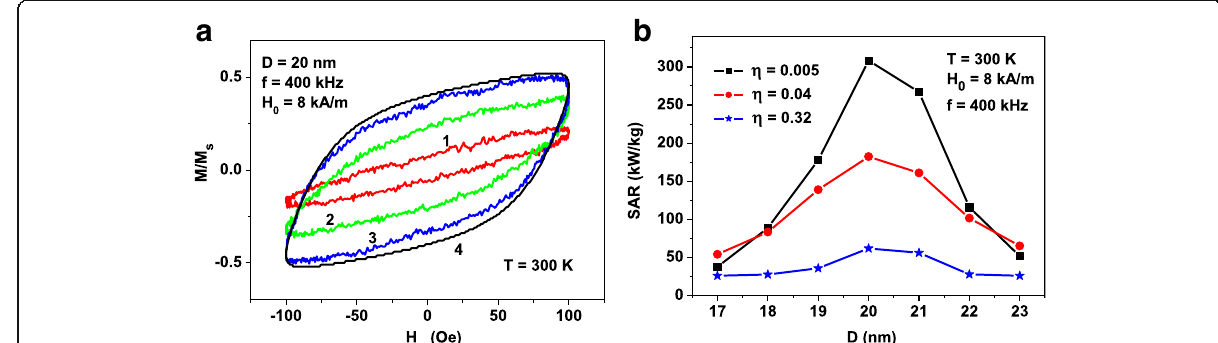
Fig. 3 ( a ) Evolution of the hysteresis loops of dilute assembly of clusters of iron oxide nanoparticles with diameter D = 20 nm for various ratios D av / D : ( 1 ) D av / D = 1.46; ( 2 ) D av / D = 2.92; ( 3 ) D av / D = 5.84. Hysteresis loop 4 corresponds to assembly of non-interacting nanoparticles of the same diameter. It is calculated by means of Eqs. (1) and (2). ( b ) SAR as a function of the average nanoparticle diameter D for dilute assemblies of clusters of nanoparticles with different packing density η